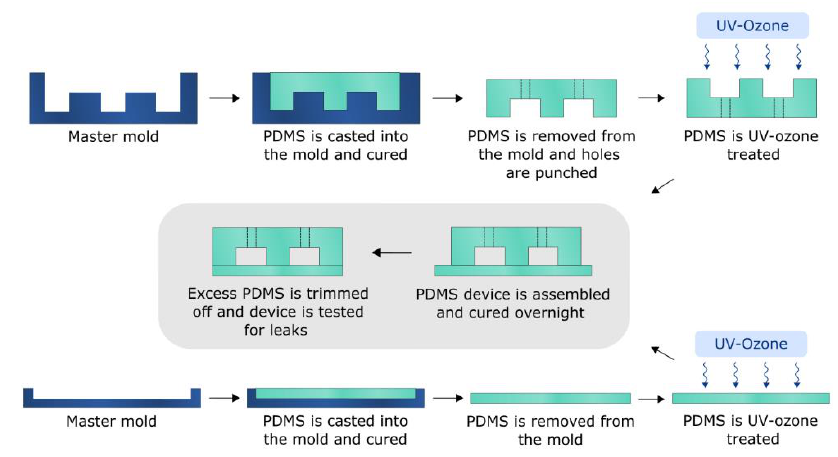
Figure 1. PDMS single-channel EV separation device fabrication workflow.